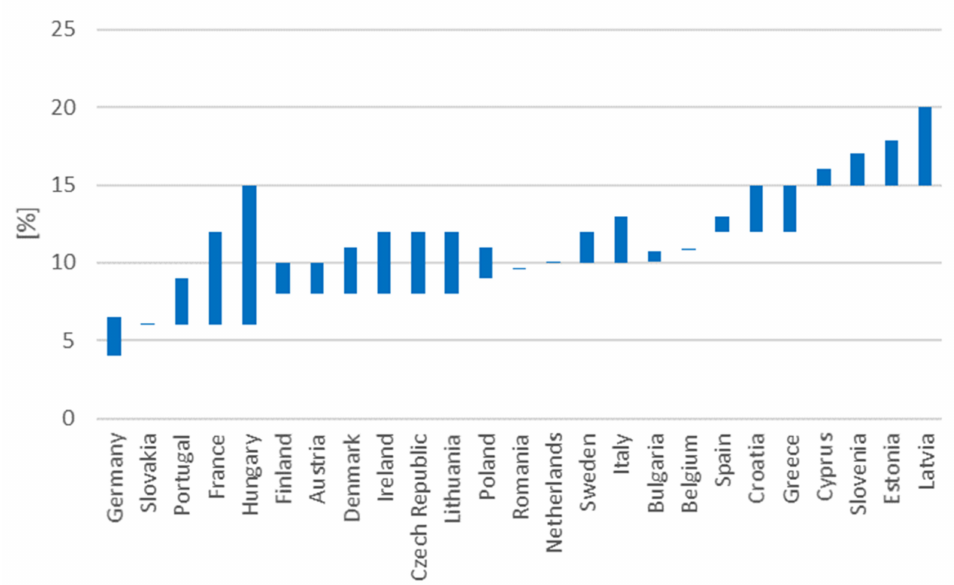
Figure 1. Cost of equity (2016) of an investment in wind energy in the European Union [26,27]. (Luxembourg and Malta—no